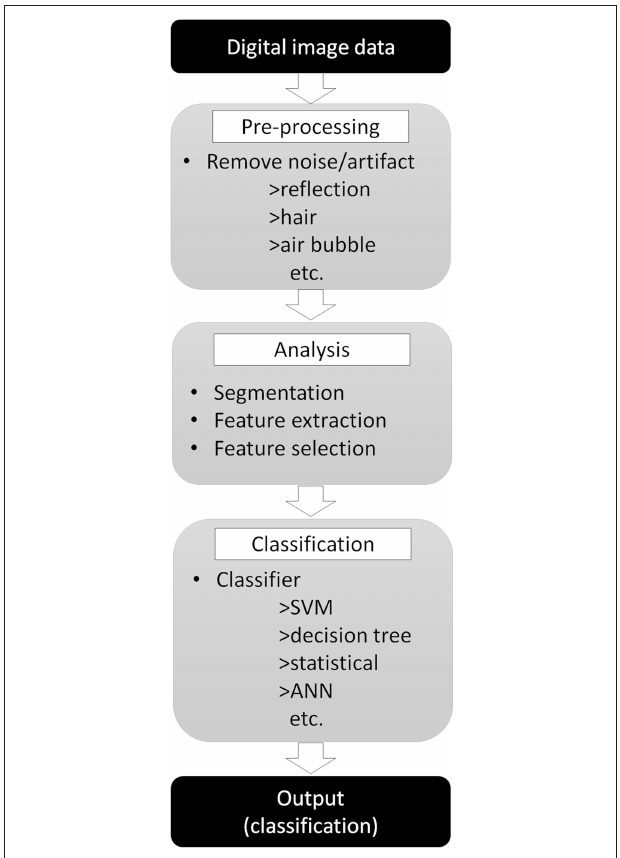
FIGURE 3 | Skin tumor classifier by “traditional” machine learning. Digital image data needs pre-processing to remove noise or artifact to improve the efficacy of the next step. Pre-processed images then analyzed to extract features required for classification step. Finally, classifier use extracted features to classify input